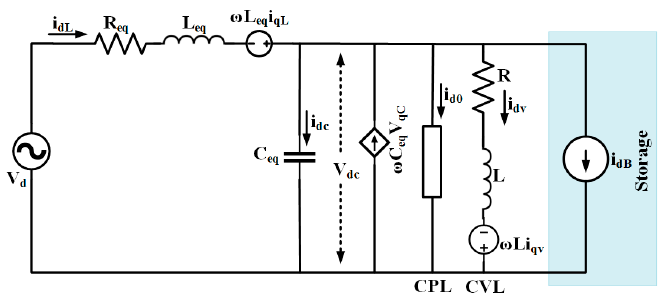
Figure 7. d-axis model of the load side real power compensation method.